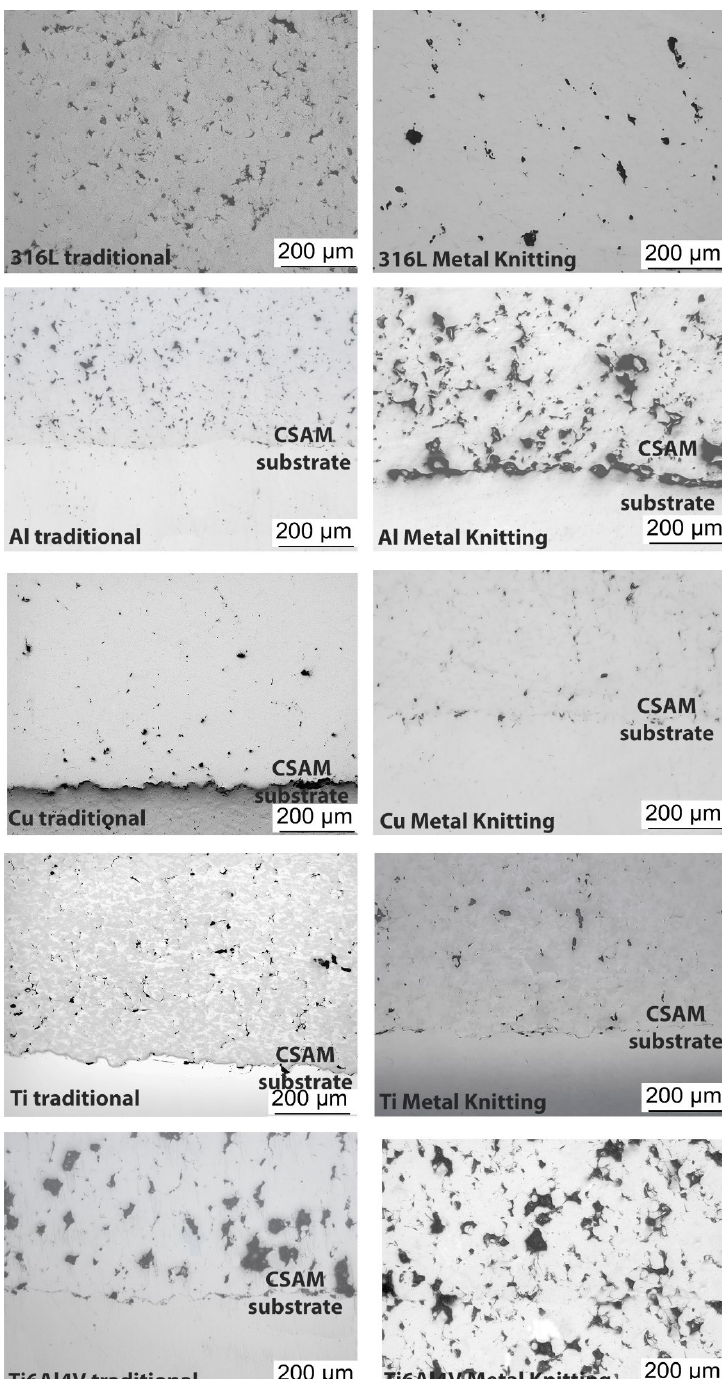
Figure 10. CSAM microstructures.